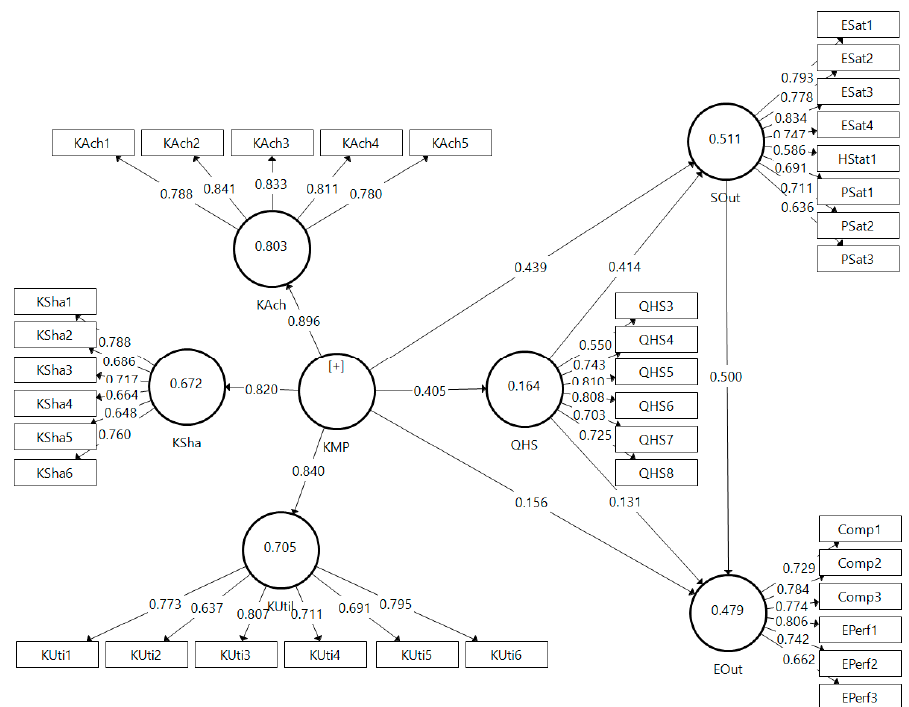
Figure 2. Measurement model computed with SmartPLS 3.2.7 (GmbH, Bönningstedt, Germany) [72].